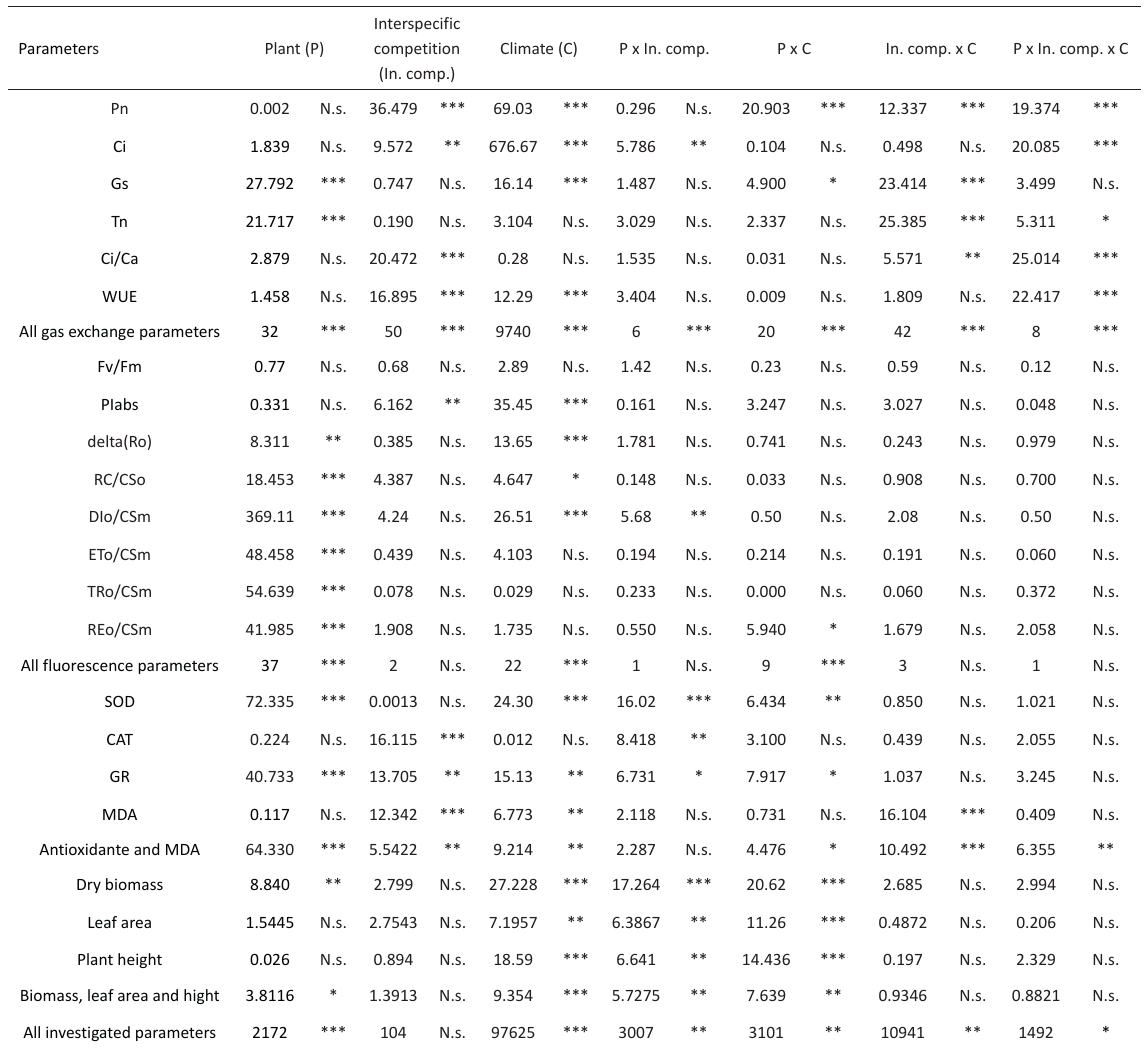
Table S 2. F value and significance of the source of variation Parameters Plant (P)